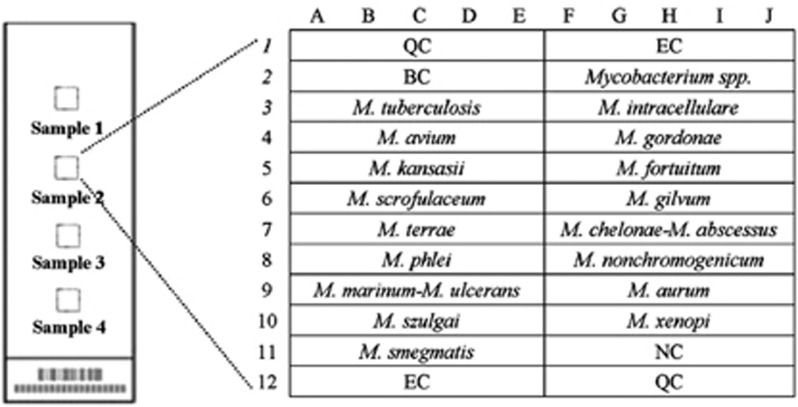
Schematic diagram of the DNA probe array for different Mycobacterium species. Seventeen oligonucleotide probes that hybridize to species-specific sequence regions of the 16S rRNA gene were chosen for identification of different Mycobacterium species. All probes were immobilized horizontally five times.